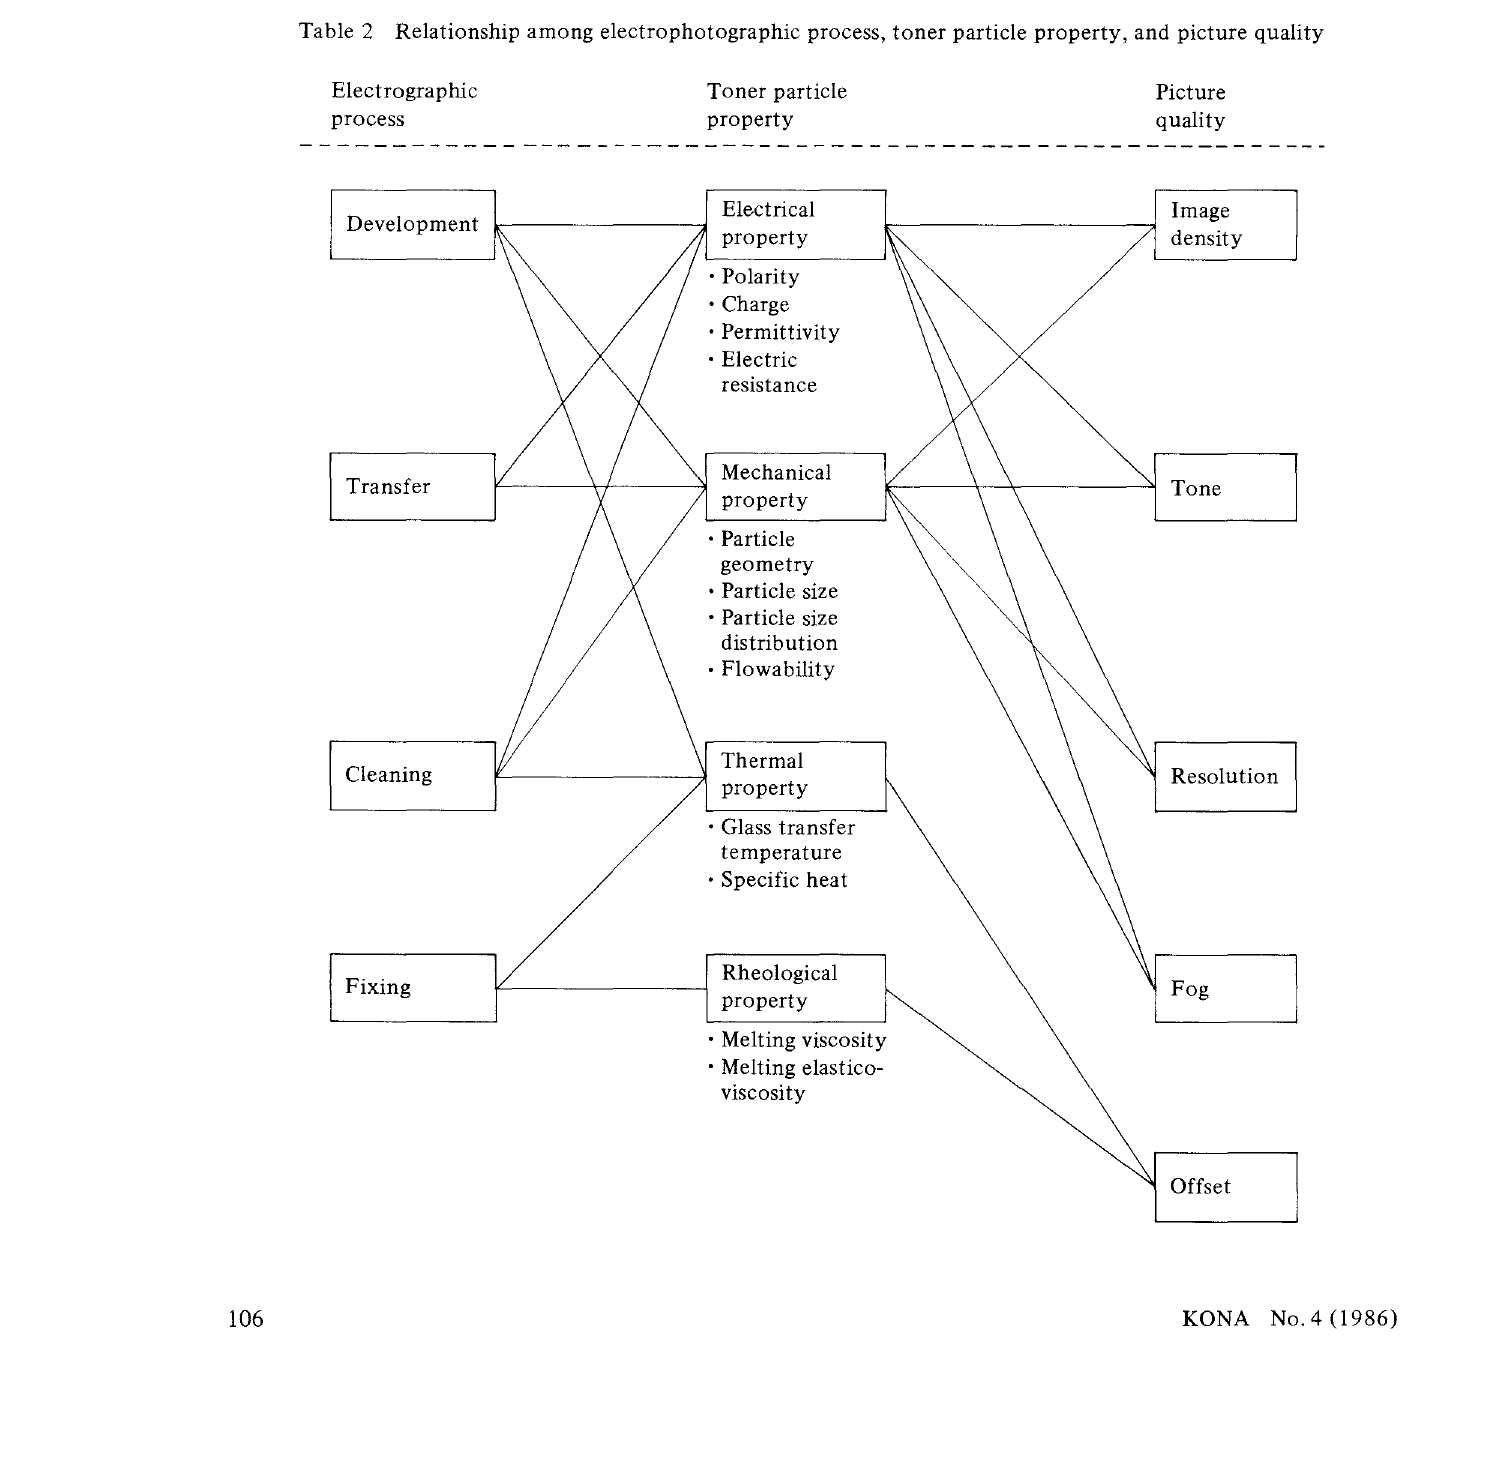
Table 2 Relationship among electrophotographic process, toner particle property, and picture